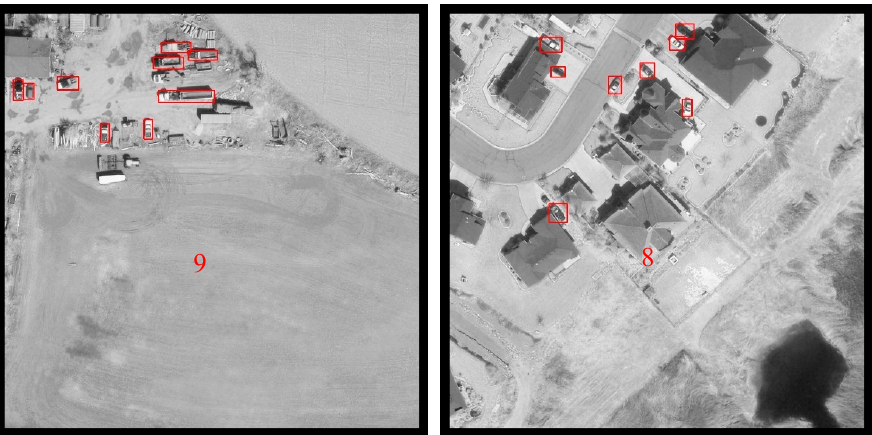
Figure 8. Comparisons between cross-entropy loss function and focal loss function. The first row contains results generated using cross-entropy loss function. The second row contains the results generated using focal loss function. The last row contains the ground truth. UCAS-AOD dataset is used in the experiments of this section for image augmentation (defined as framework 1.3). The UCAS-AOD dataset contains colour images provided from Google Earth and the size of vehicles is similar to the vehicle sizes in VEDAI dataset. In order to reduce the impact between these two datasets, the automobile images in UCAS-AOD dataset have been converted to grayscale image (details can been seen in Figure 9).In the experiments, the training dataset contains both UCAS-AOD images and the VEDAI training data. However, evaluating the dataset is randomly selected from VEDAI data only.